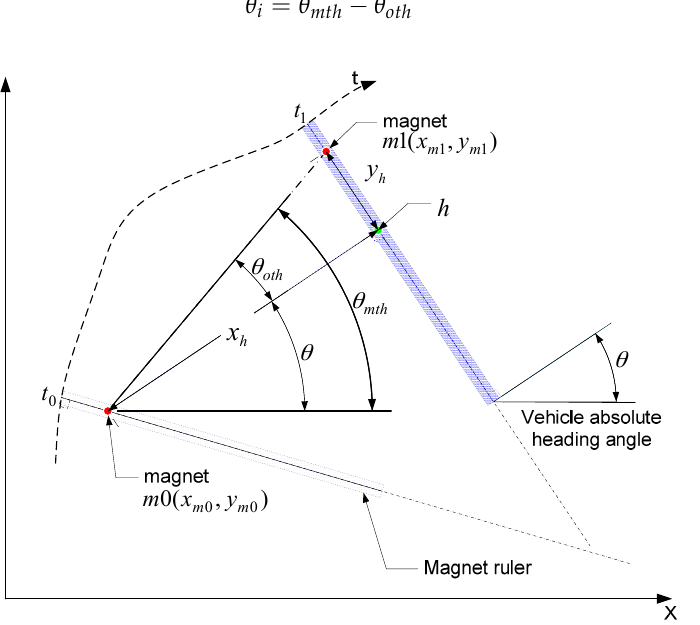
Figure 6. Concept of heading angle estimation.